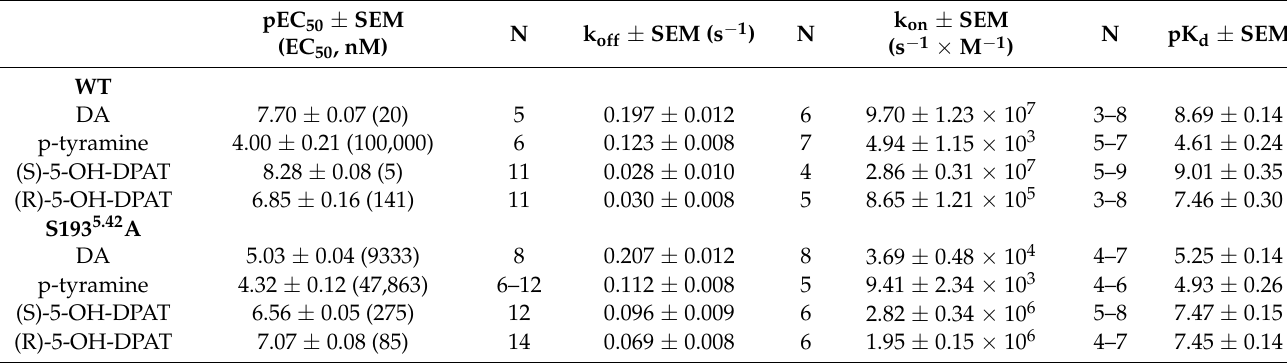
Table 1. Agonist EC 50 s, estimated forward (k on ) and reverse (k off ) rate constants, and kinetic K d s at WT and S193 5.42 A mutant D 2